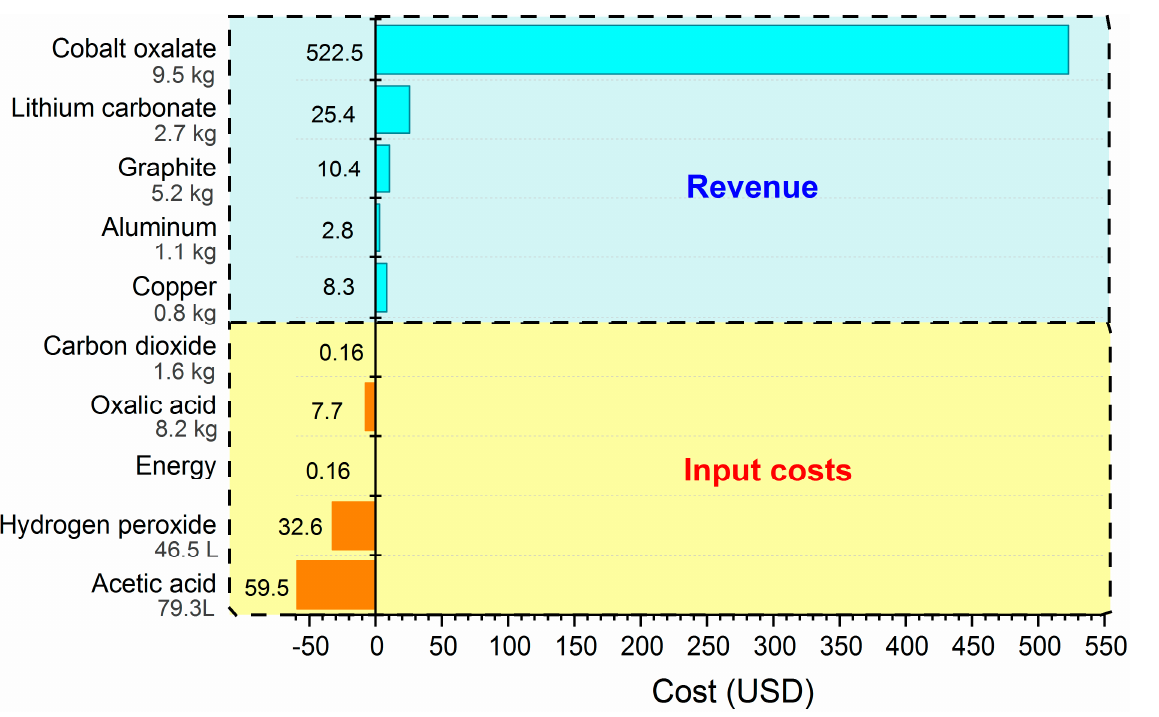
Figure 7. Costs of the recycling process of 1000 cellphone LIB modules.